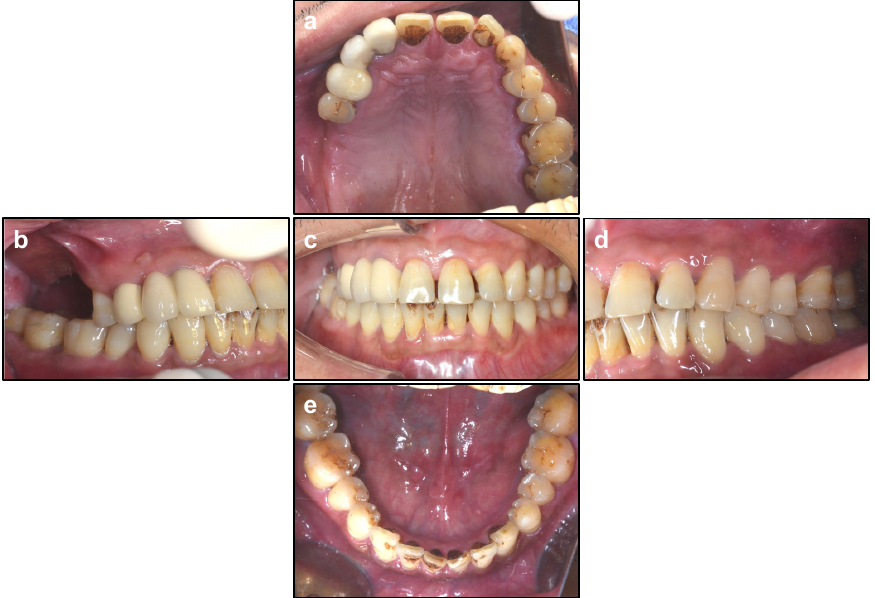
Figure 1. Occlusal Relationship. ( a ) Maxillary. ( b ) Right. ( c ) Occlusal. ( d ) Left. ( e ) Mandibular.